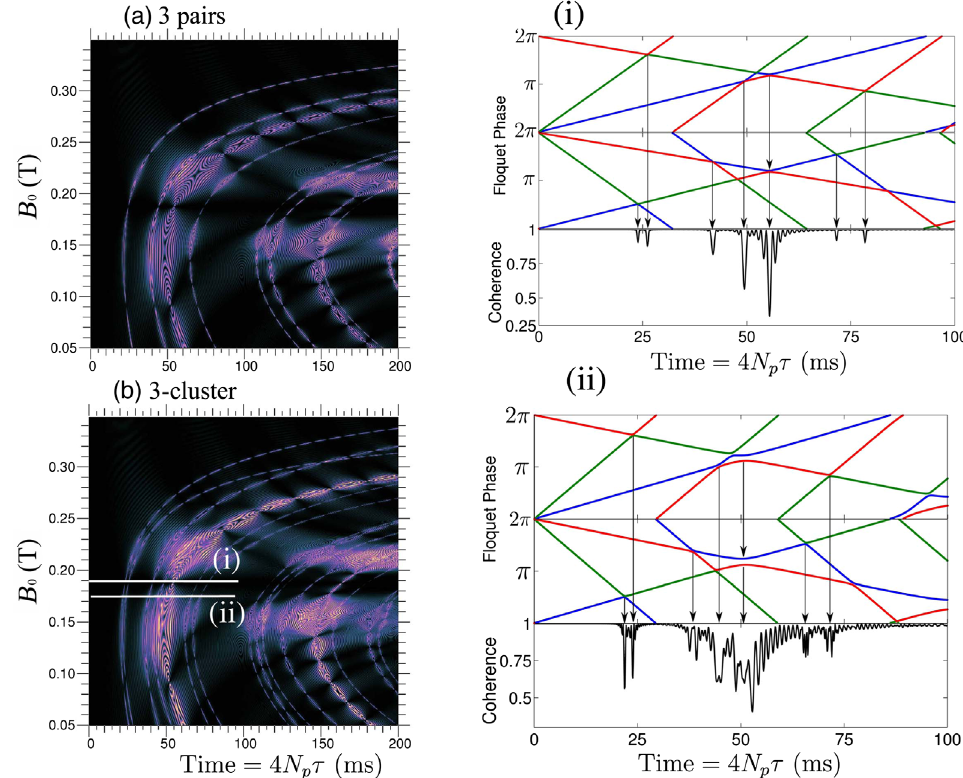
FIG. 5. Fingerprinting multiple environmental spin cluster pairs via their decoherence “ bar codes ” illustrates the effect of 3-body correlations. The figure shows the coherence as a function of magnetic field B 0 and pulse interval τ , calculated with a full numerical propagation under the total Hamiltonian for N p ¼ 100 . Panel (a) denotes three independent pairs while panel (b) shows three interacting spins, with otherwise equivalent dipolar couplings and intrabath interactions as illustrated in Fig. 1(b). One evident difference (and signature of a cluster of three spins) is the doublets due to the two separate subspaces of the three interacting spins. The splittings are directly related to the interactions. For the 3-cluster, in fact, there is a secular contribution from interactions between spins, greatly amplifying their contribution. The two right-hand panels (i) and (ii) show single traces corresponding to the cuts in (b) as well as the six corresponding eigenphases: in case (i), in a weak-coupling regime the dips are narrow and the eigenphases behave like three independent pairs; the eigenvalues correspond to conjugate pairs (with blue, red, and green lines denoting the three pairs). In case (ii) there is stronger coupling, the avoided crossings of the corresponding eigenphases are broader, giving rise to the features shown in the coherence